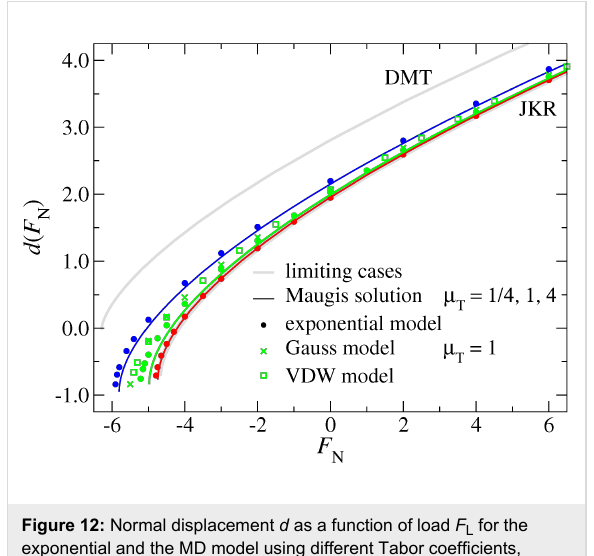
Figure 12: Normal displacement d as a function of load F L for the exponential and the MD model using different Tabor coefficients, ranging from μ T = 0 (DMT, top) to μ T → ∞ (JKR, bottom). For the Gauss and the exponential model, data is only shown for μ T = 1. Color coding: μ T = 4 (red), μ T = 1 (green), and μ T = 1/4